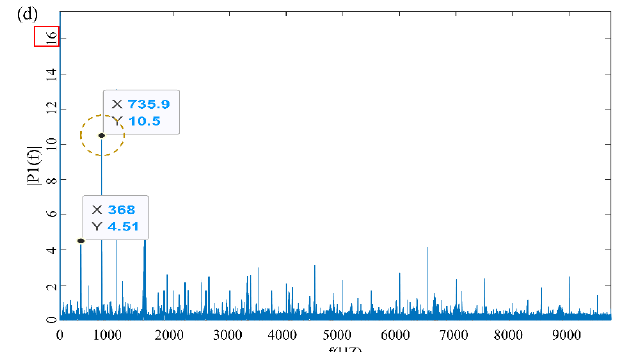
Figure 6. Gear running at each stage spectrum map, spectrums of ( a ) dead load and ( b ) impact loading in running in the wear stage, ( c ) impact loading in the severe wear stage, ( d ) impact loading in failure time.